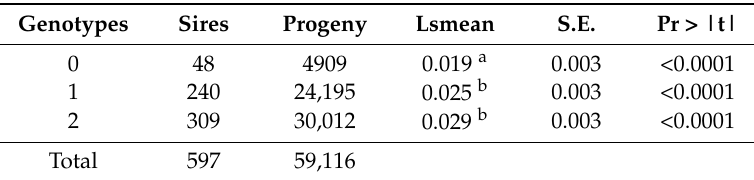
Figure 4. Manhattan plots showing genome-wide association results for pneumonia, pleuritis, pericarditis, and joint disorders. SNPs are plotted on the x -axis according to their position on each chromosome against statistical association with these traits on the y -axis. The horizontal line indicates genome-wide significance ( p < 1.0 −6 ). Table 3. Effect of the genotype of the sire with respect to most significant SNP on chromosome 7 on pericarditis in their progeny.